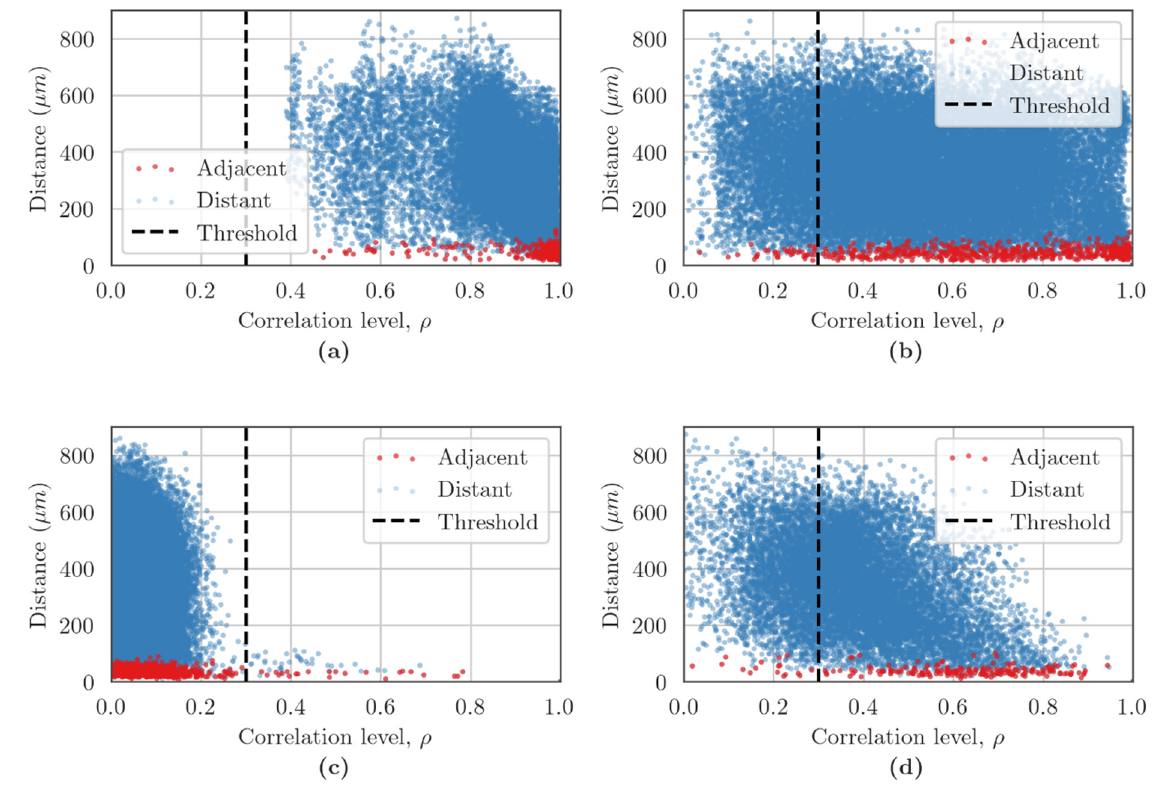
Figure 7. Dependence between the correlation level and the distance of cells pairs in primary cortical cultures on the third day of the post-hypoxic period. The adjacent cell pairs with their soma in direct contact are highlighted in red, and distant cell pairs in blue: ( a ) Sham, ( b ) Gap19, ( c ) Hypoxia, ( d ) Hypoxia+Gap19.